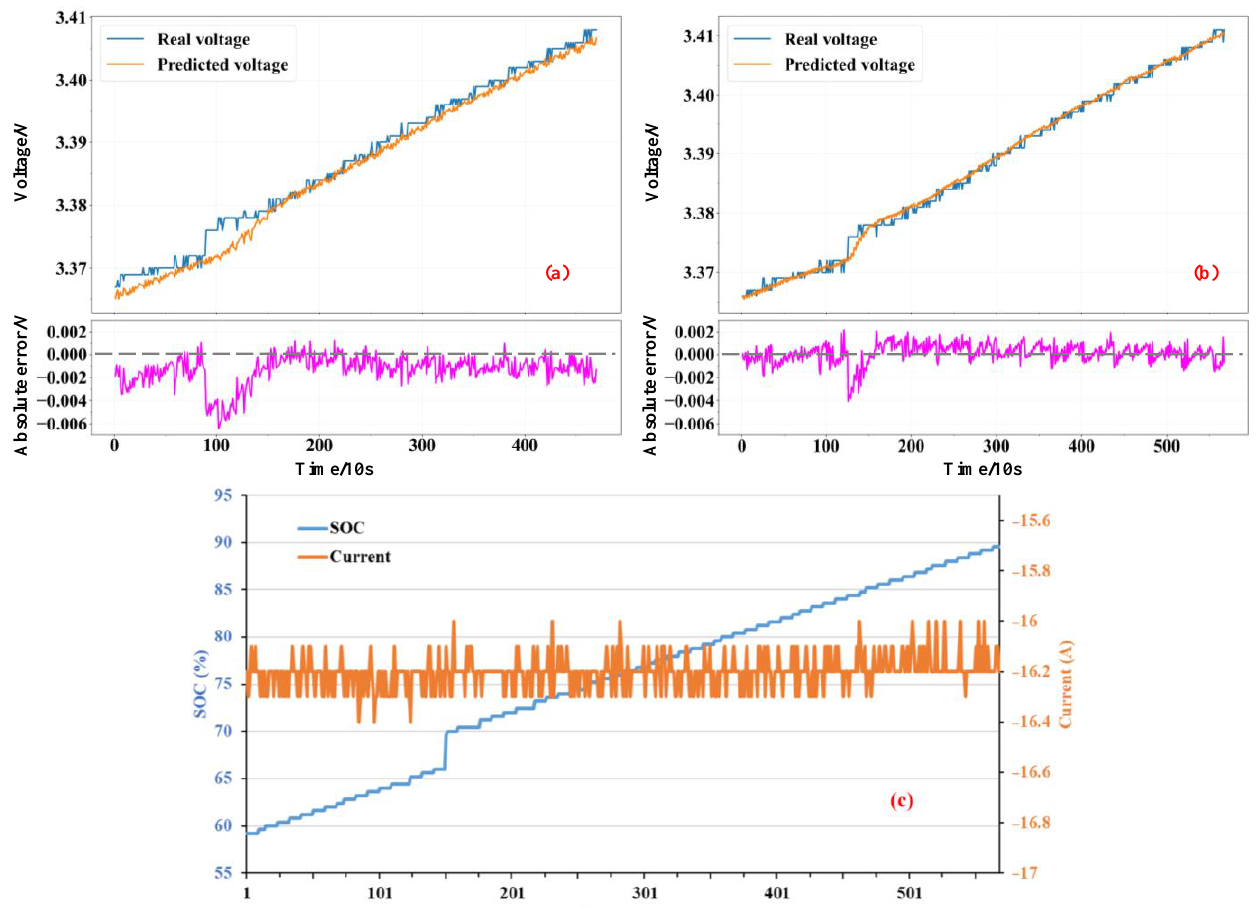
Figure 9. The voltage prediction results before and after hyperparameter optimization: ( a ) prediction results before optimization; ( b ) prediction results after optimization; ( c ) SOC and